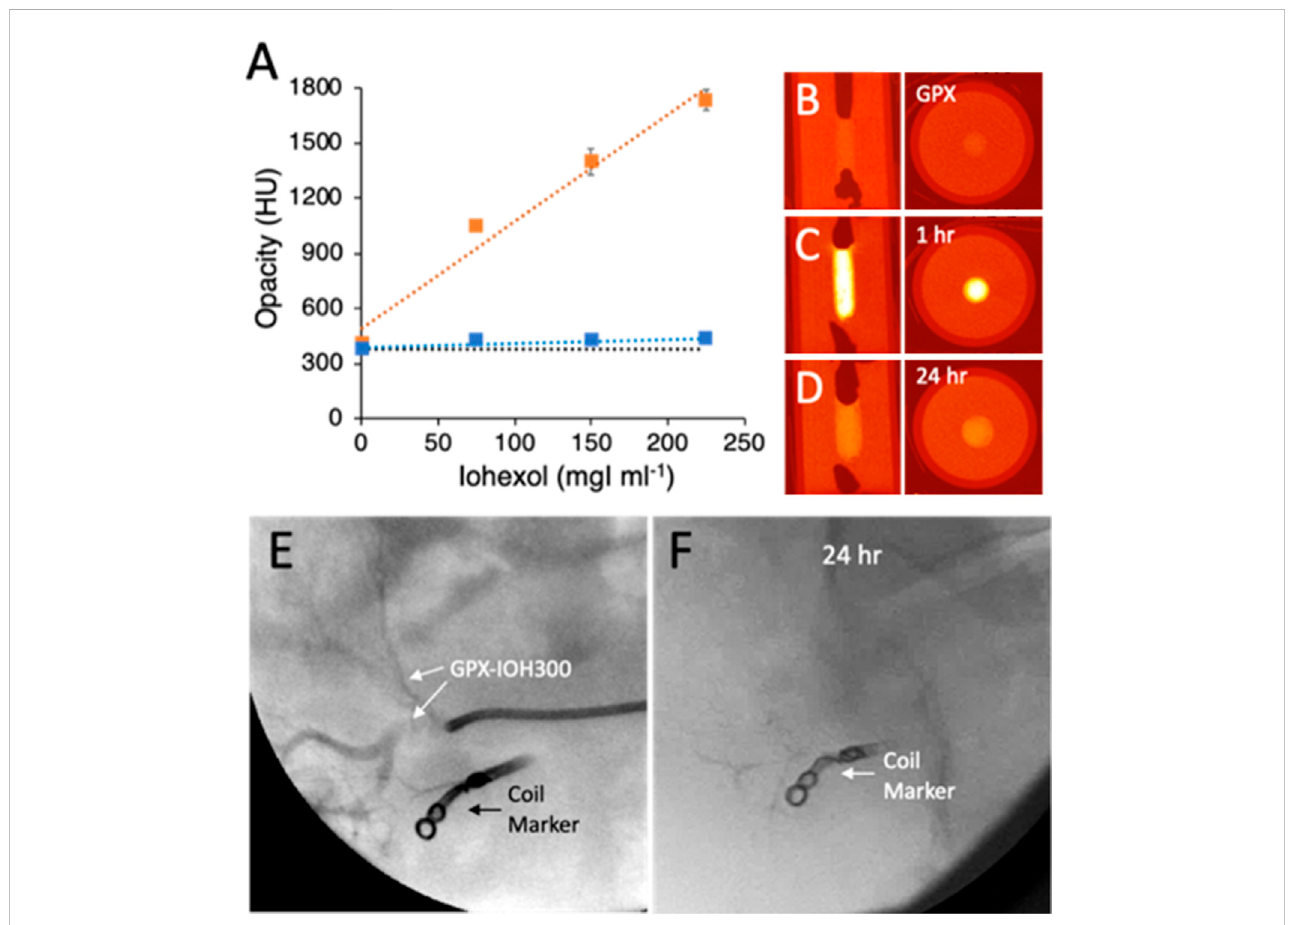
FIGURE 6 (A) RadiopacityofGPX350withincreasing concentrations ofiohexol ingelatin tissue phantoms,after 1 h(orangesymbols)and 24 h(bluesymbols).Data points are the mean of three measurements and error bars represent ± 1 SD. Dotted lines are linear fi ts to the data points ( R 2 ≥ .95). The black dotted line indicates the background opacity of GPX350. (B) Radial and axial microCT images of tissue phantoms containing GPX350. (C) GPX350-IOH75 after 1 h. (D) After 24 h. (E) Injection of GPX350-IOH300 into swine renal artery. (F) GPX350 was no longer visible in a fl uorogram 24 h